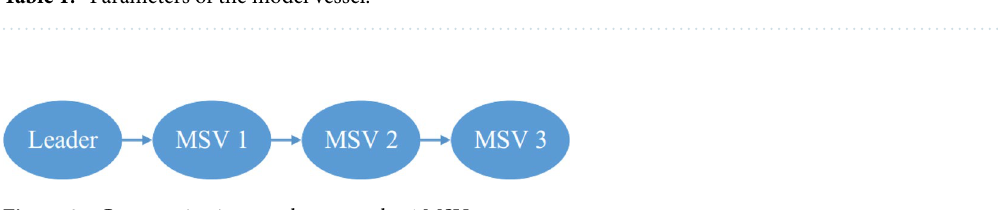
Figure 2. Communication graph among the 4 MSVs.